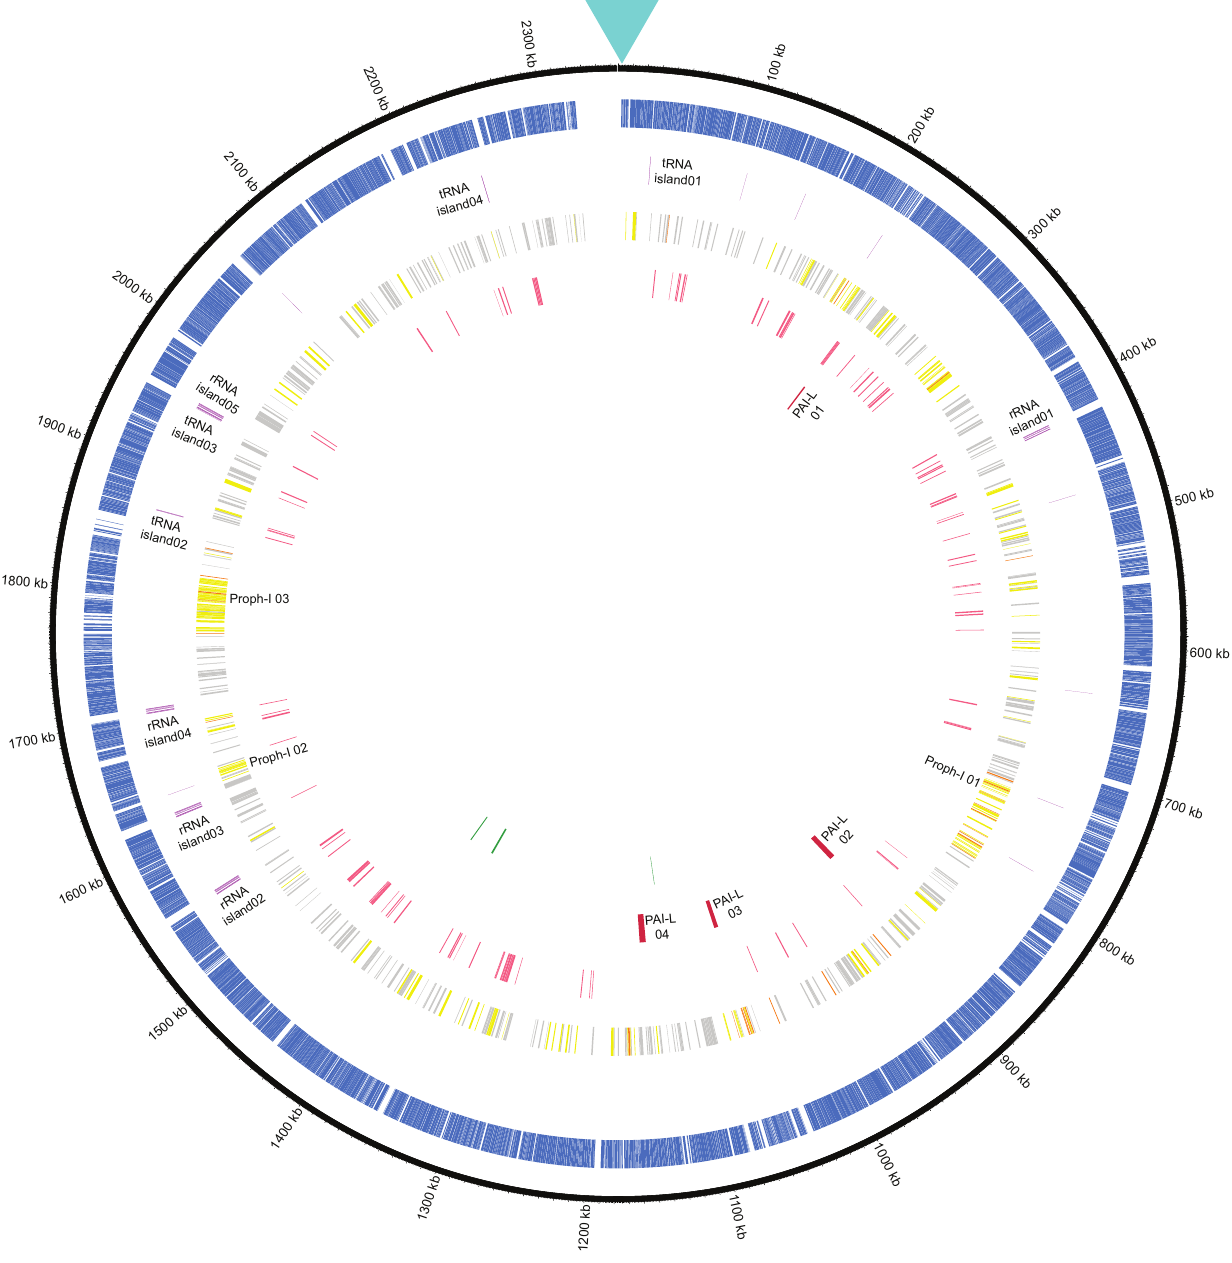
the Haemophilus spp yet fully sequenced.